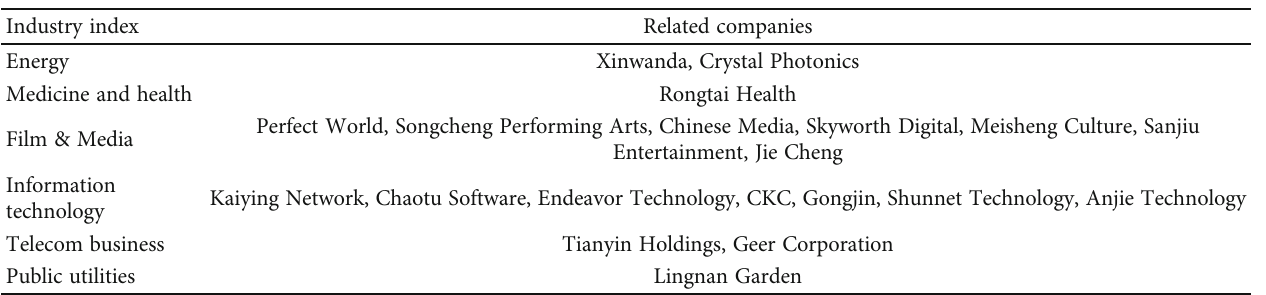
Table 5: Industry index results.